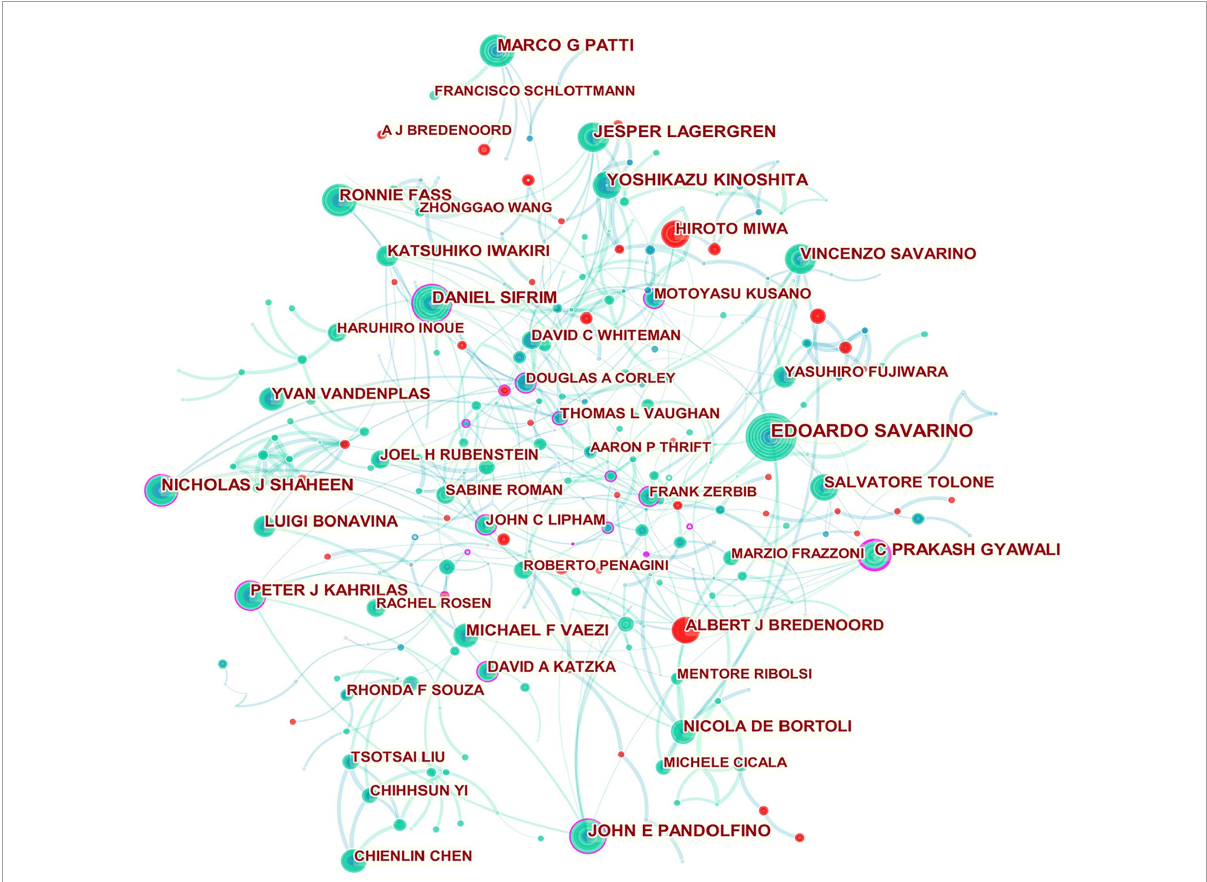
FIGURE4 Network of authors in GERD research. In the network map, a node represents an author. The volume of each node (author) corresponds to the number of publications, and connecting lines between nodes indicate bidirectional relationships between the authors; the thickness of the line indicates the strength of the bidirectional collaborative relationships. Isolated authors lack any collaboration. A node with a high betweenness centrality links two or more large groups of nodes. A node with a high betweenness centrality score exerts a strong influence on the network. A purple trim indicates a high betweenness centrality. Red tree rings indicate bursts of citation. The greater the thickness of the red tree rings, the greater the bursts for the corresponding